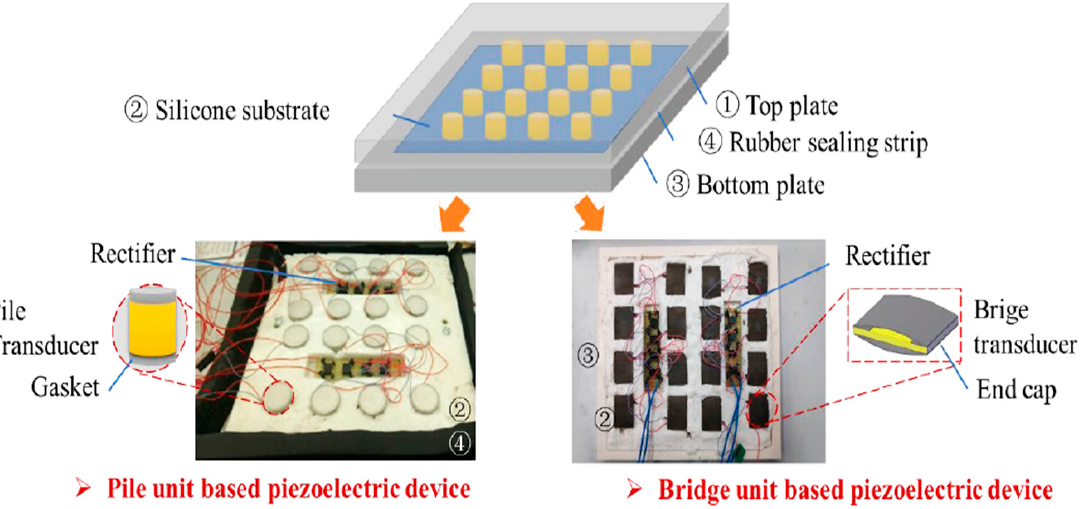
Figure 9. Structures of two piezoelectric slab harvesters presented in [40] (Reprinted with permission from Ref. [40]. 2022, MDPI).